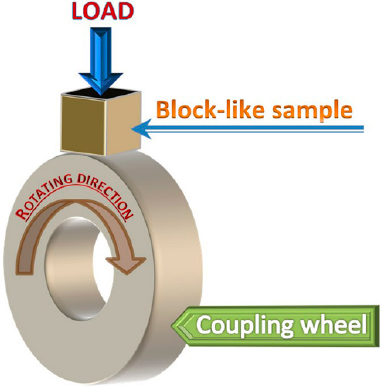
Figure 1. Schematic illustration of block-on-wheel mode dry sliding wear test.